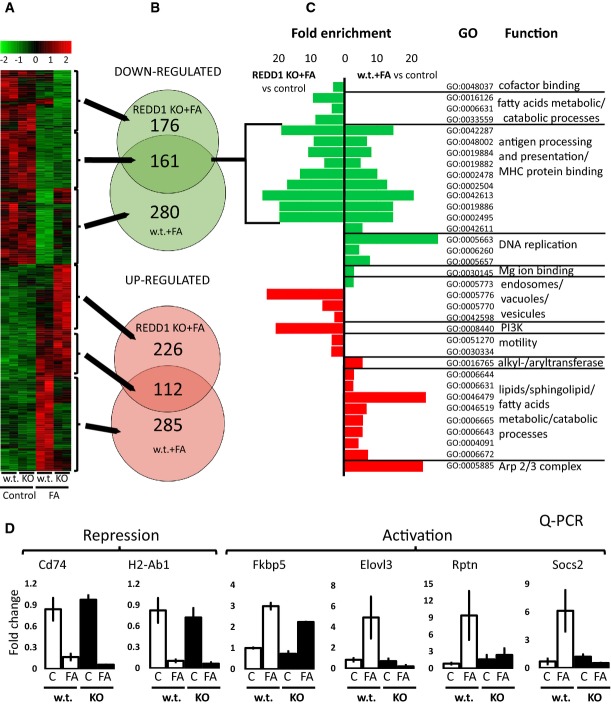
Global effect of REDD1 KO on the expression of glucocorticoid-responsive genes in murine epidermisREDD1 KO and isogenic B6x129 mice were treated topically with FA (2 µg) or vehicle (acetone) for 24 h, and RNA was extracted from the epidermis and used for microarray analysis.A A heatmap of gene expression as analyzed by the Mouse Whole-Genome Gene Expression BeadChips (Illumina). Columns show normalized gene expression for individual animals (red: increased, green: decreased expression).B Venn diagrams show overlap of differentially expressed genes between REDD1 KO and wild-type mice (adjusted P < 0.05). Arrows connect sections of the heatmap with corresponding Venn diagrams.C Most enriched gene ontology (GO) categories for biological processes and molecular functions (fold-change enrichment ≥ 3, P < 0.01), associated with transrepression and transactivation of the glucocorticoid-responsive genes in REDD1 KO and wild-type mice.D Array validation by Q-PCR for genes from the different GO categories. Note: lack of overlap in GO categories between KO and wild-type mice associated with up-regulated genes and significant overlap in the function of down-regulated genes.
Data information: We used for array analysis two individual RNA samples/condition. Statistical analysis of DNA arrays is described in Materials and Methods. Statistical analysis of array validation is shown in Supplementary Fig S3.